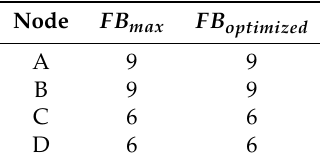
Table 4. Repeal-flooding boundary estimation keeping the largest value of FB est